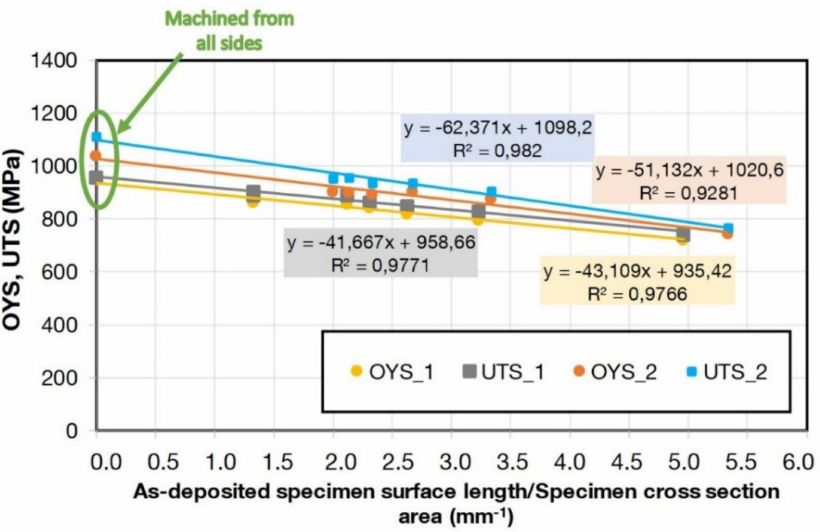
Figure 17. Dependence of OYS and UTS values on specimen surface length / cross section ratio for SLM-processed flat specimens the for first (“1”) and second (“2”) batch of